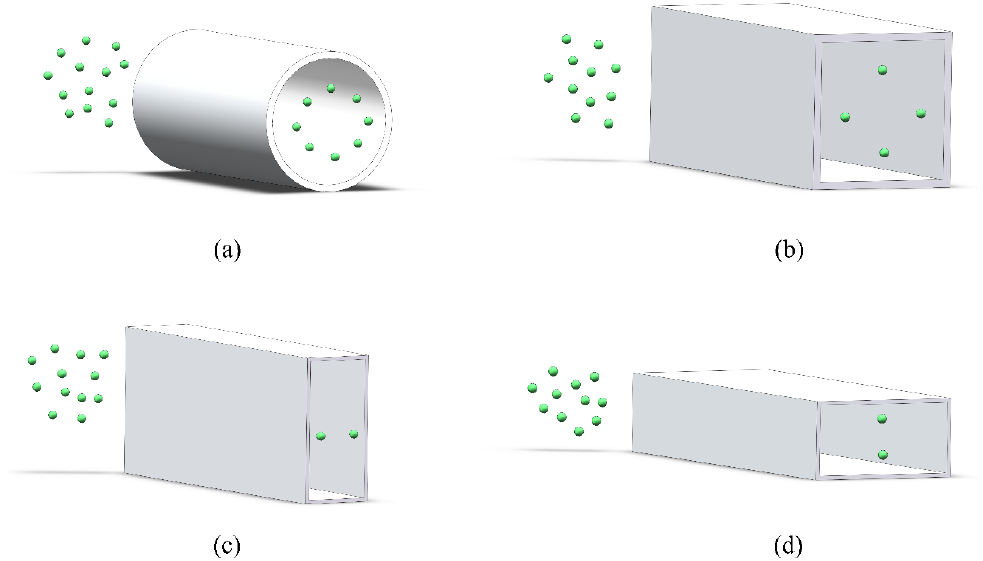
Figure 1. Schematic of the focusing position of particles migrating through channels with different cross-section shapes: ( a ) circular channel; ( b ) square channel; ( c ) high-aspect-ratio rectangular channel; and ( d ) low-aspect-ratio rectangular channel.